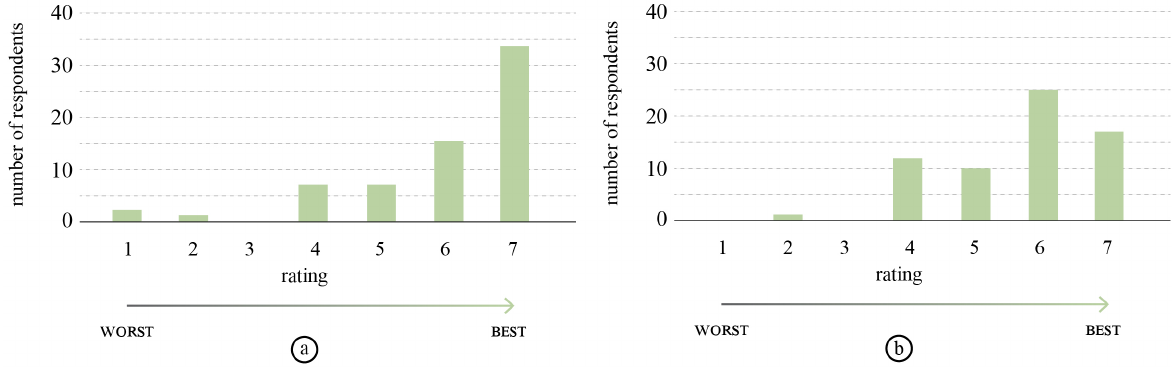
Figure 3. (a) Bar chart showing the evaluation of the Methodology in terms of clarity. (b) Bar chart showing the evaluation of the Methodology in terms of